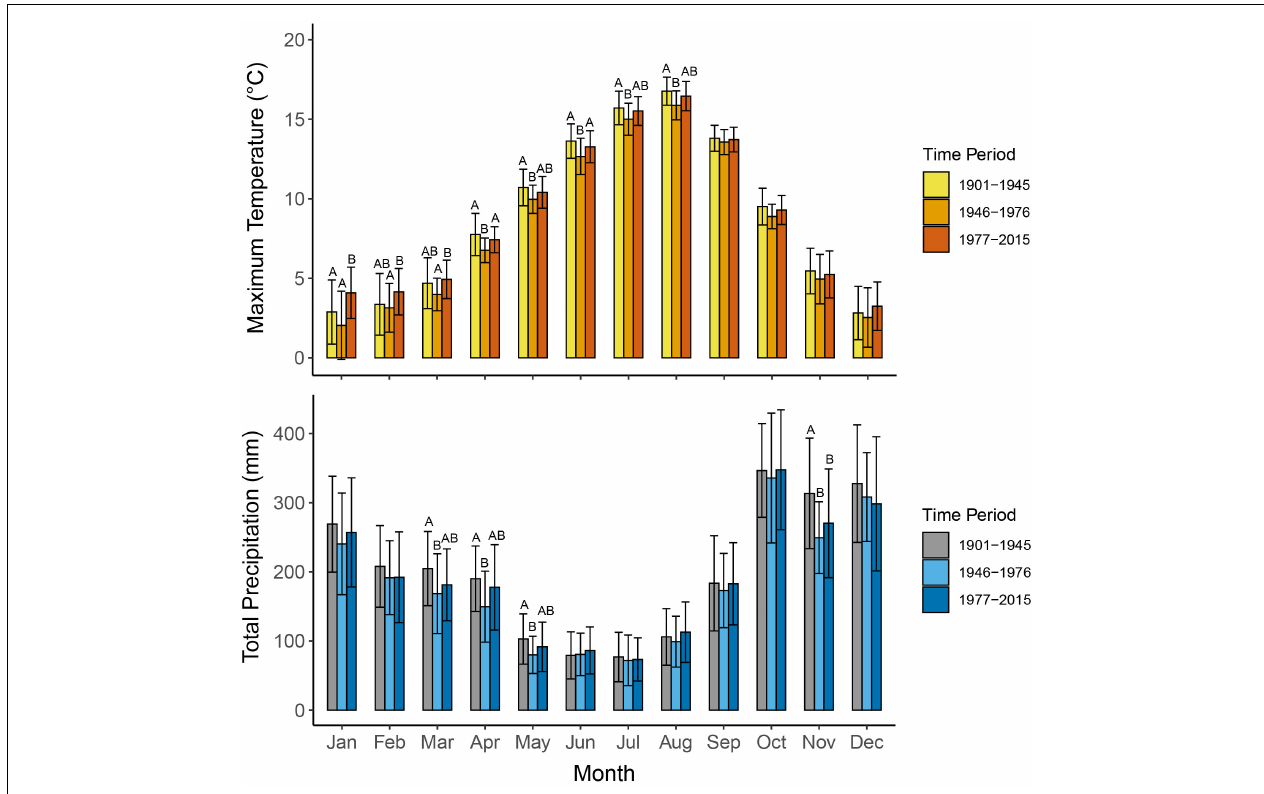
FIGURE 3 | Comparison of monthly maximum temperature and total precipitation between time periods. Each bar represents a monthly temperature or precipitation value averaged across one of the three time periods. Error bars represent standard deviation around the mean. Different letters indicate a significant difference between phases ( p <